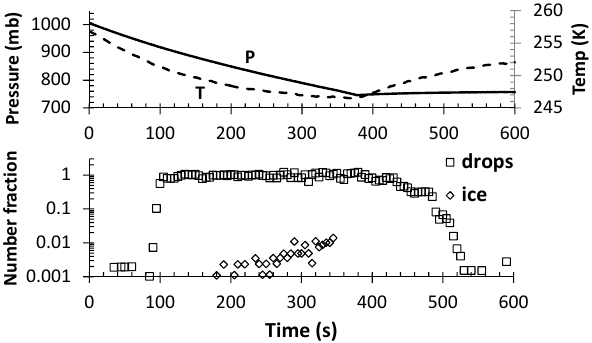
Figure 3. Temperature, pressure, and the number fractions of par- ticles in droplets and ice crystals for the ICIS 2007 AIDA cloud expansion experiment #22 using Saharan dust aerosols. The data (0.2Hz as plotted) indicate the complete activation of particles to cloud droplets and minor fractions of these particles activating as INPs as the chamber temperature cools. Calculation of ice active fraction is suspended at the point of strong ice crystal sedimenta- tion after